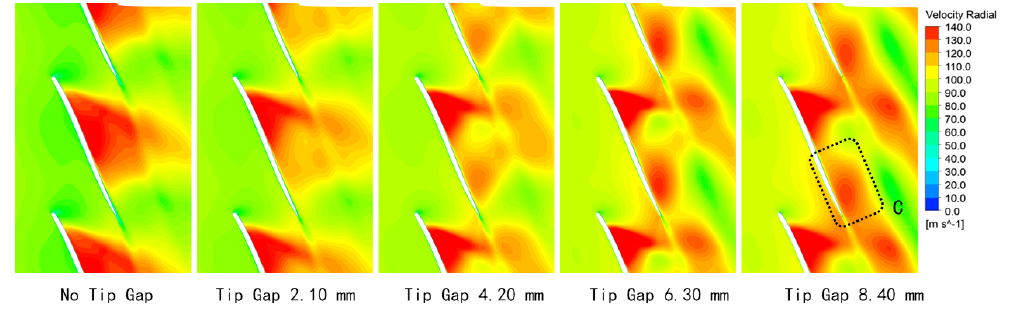
Figure 14. Contour of radial velocity on the 92% span